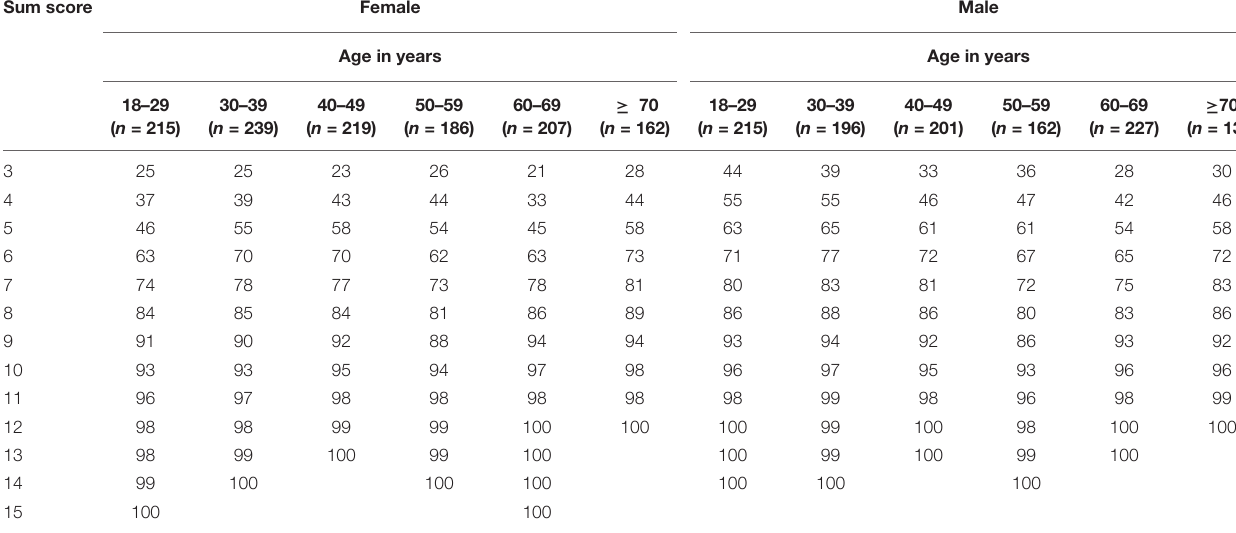
TABLE 7c | Normative percentile ranks for the RBI